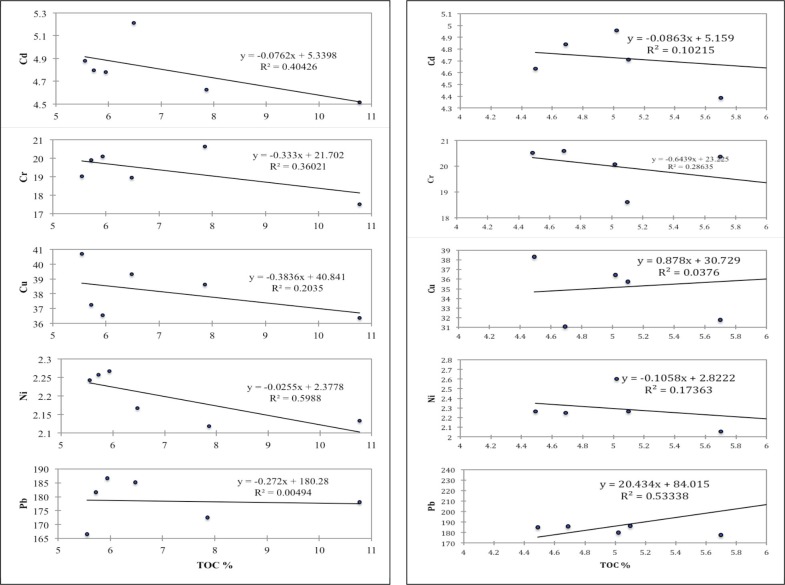
Scatter plots of trace metals and total organic contents in Douglas creek (left) and Qua Iboe estuary (right).